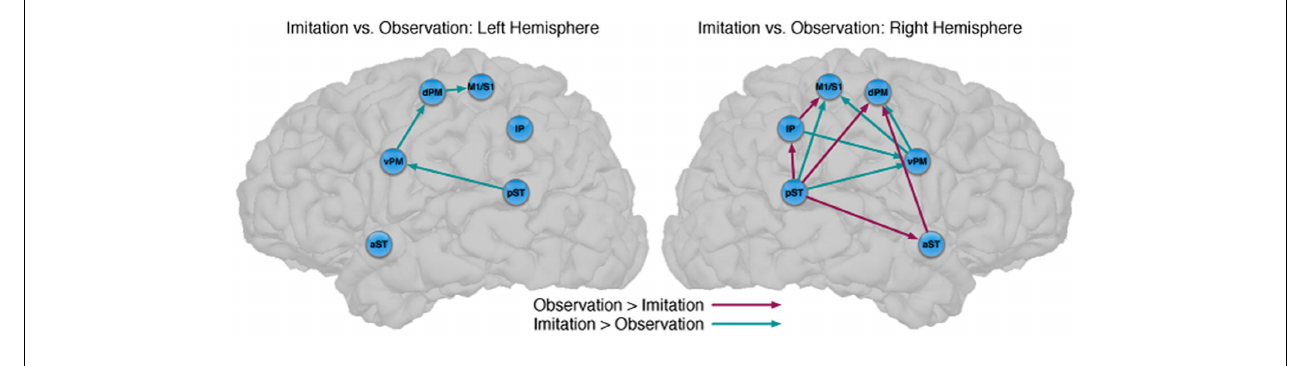
weights for Observation vs Imitation.The flow of information in the LH might suggest a pathway to execute speech during Imitation. For a key to abbreviations, please see the legend to Figure 2 and Table 1 .